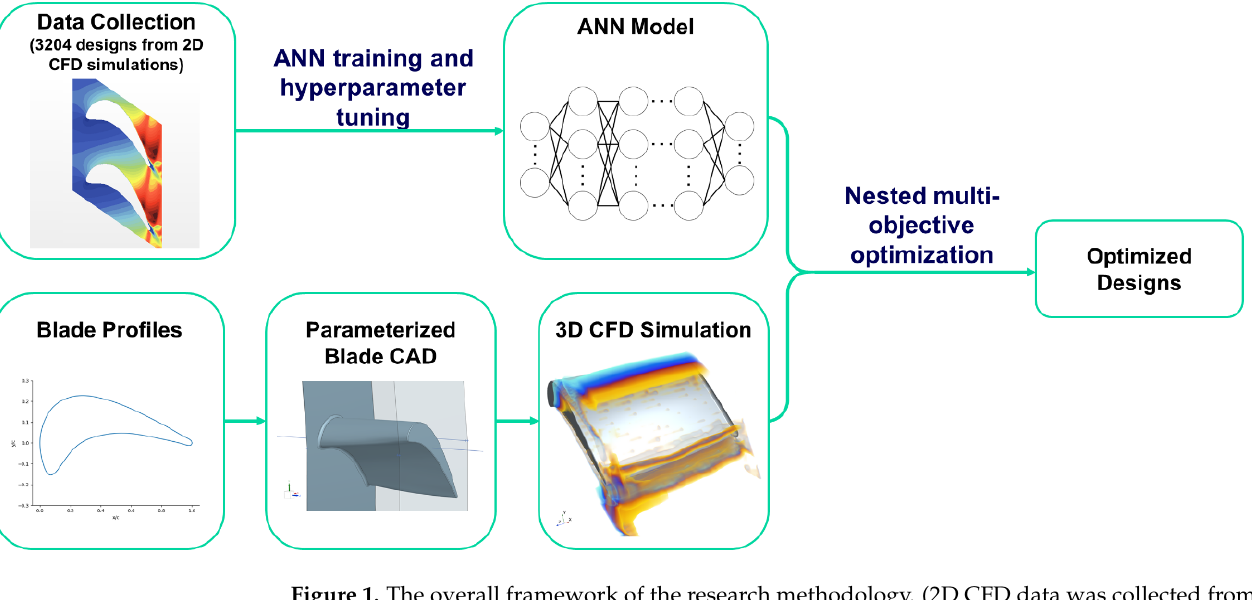
Figure 1. The overall framework of the research methodology. (2D CFD data was collected from a previous study